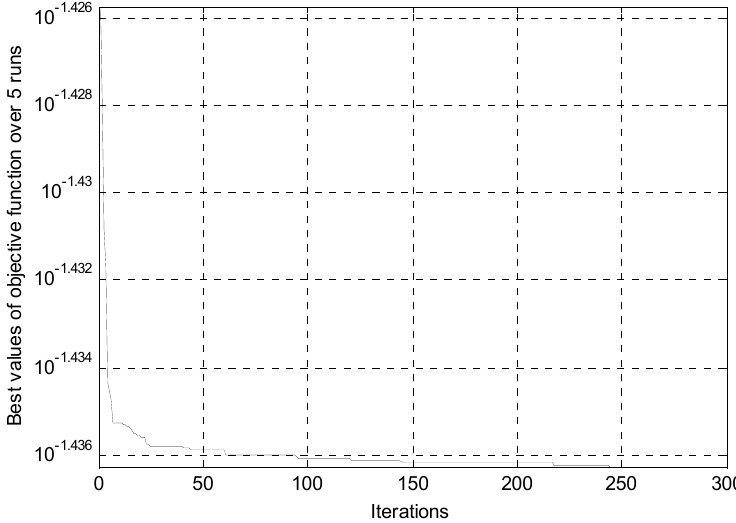
Figure 5. Best values of the objective function over five runs for the ABC algorithm.